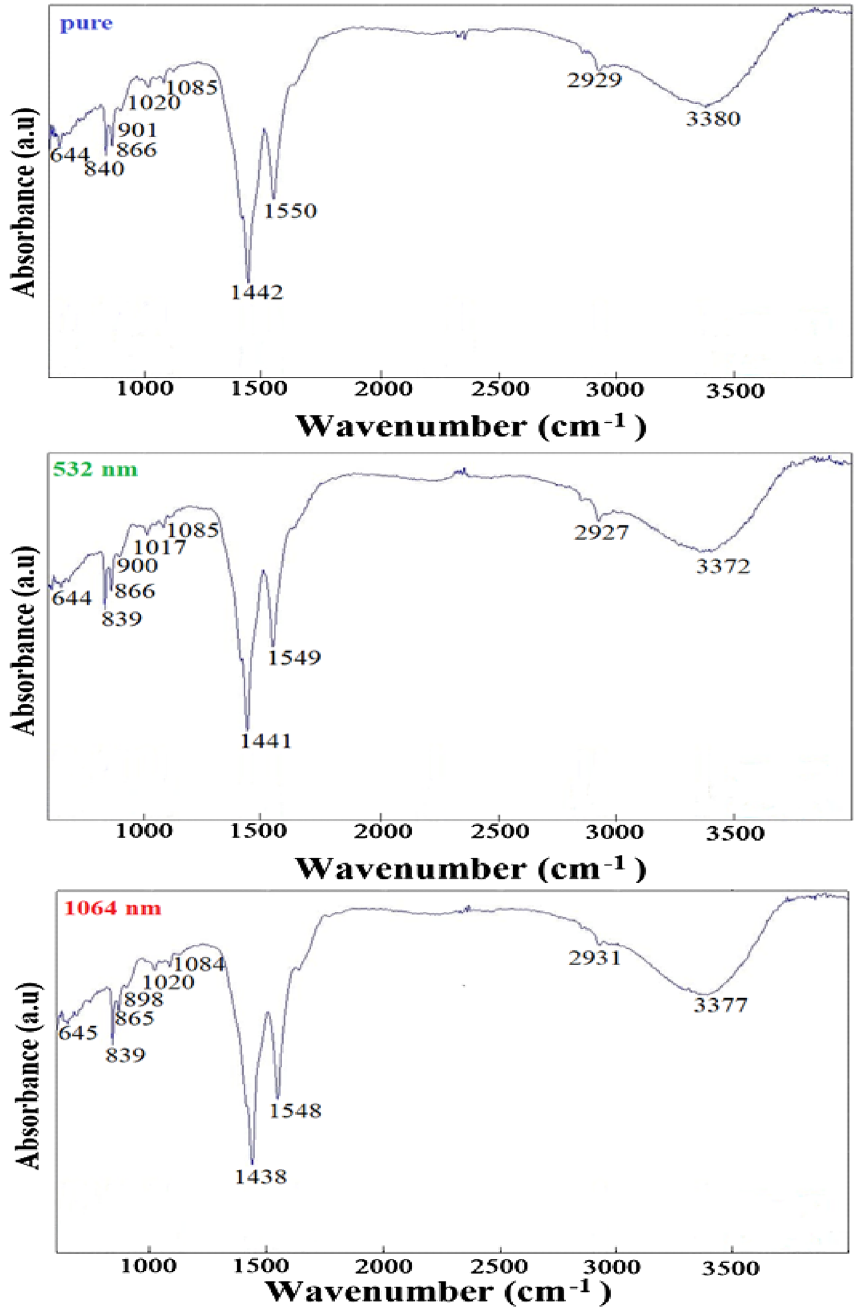
Figure 7. The FTIR Absorbance spectra for the ZnO NPs before and after